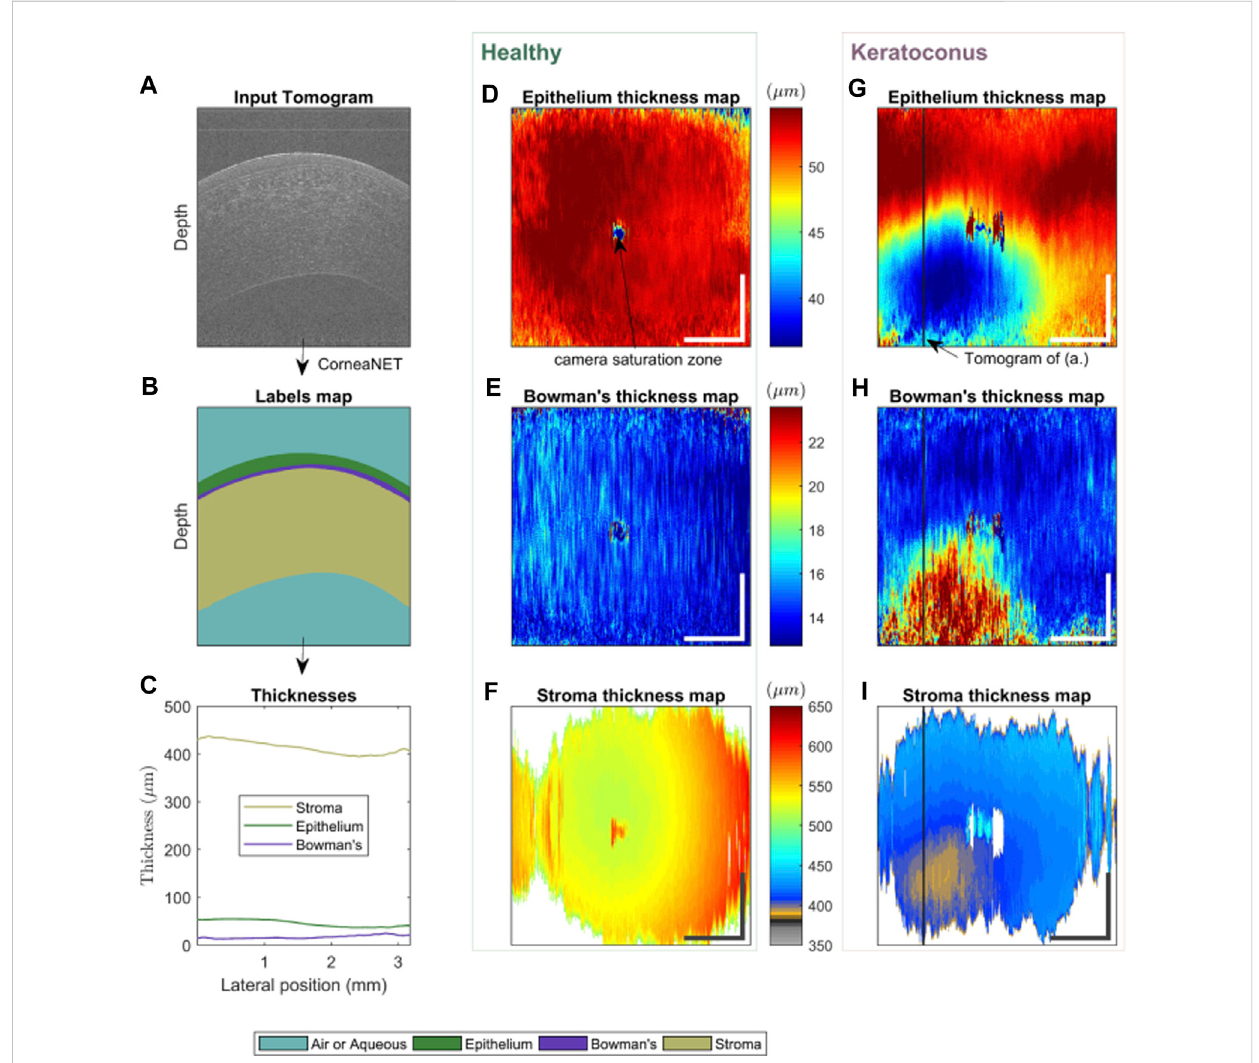
FIGURE 3 UsingCorneaNet,thethicknessesoftheepithelium,stroma,andBowman ’ slayerwerecomputedinanormalandaKCcase(DosSantosetal.,2019). The healthy case shows close to uniform thicknesses for all three layers. In contrast, for the KC case, the epithelium and stroma are thinner in a speci fi c regionofthecornea,andBowman ’ slayeristhicker. (A – C) Thicknesscalculationinonetomogram. (A) UHR-OCTtomogramofakeratoconuspatient, (B) corresponding labelsmap computed usingCorneaNet. (B) Thicknesses ofthethree corneal layers computed usingthelabelmaps. (D – F) Thickness maps in a healthy subject case. (G – I) Thickness maps in a keratoconus case. The thickness scale bar is shared by the maps horizontally. Scale bar: 1